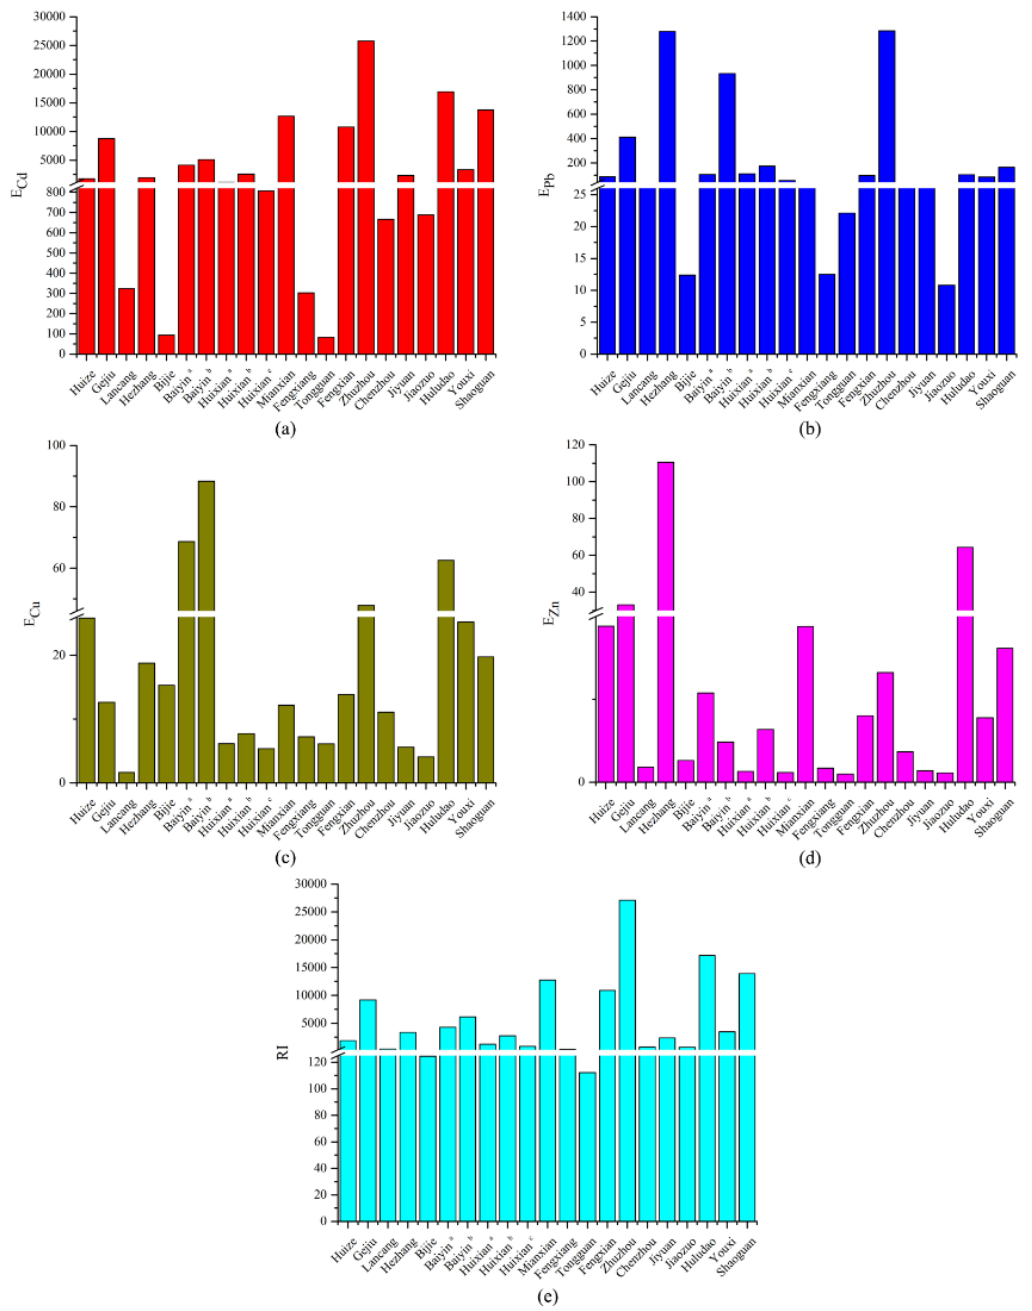
Figure 5. The potential ecological index of heavy metal in soil. ( a ) potential ecological risk index of Cd; ( b ) potential ecological risk index of Pb; ( c ) potential ecological risk index of Cu; ( d ) potential ecological risk index of Zn; ( e ) comprehensive potential ecological risk index.